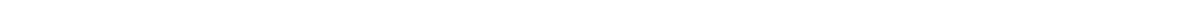
Fig. 3 Transcriptome-wide analyses of puri fi ed mouse astrocytes treated with EphB1 or IL-6. a Graphs show the total of changed transcripts induced by EphB1 or IL-6 treatment. b Diagram demonstrating the number of treatment speci fi c and commonly upregulated and downregulated genes ( n = 2 independent cultures from 6 mice; FDR ≤ 0.1). c Unsupervised hierarchical clustering of control astrocytes (ACs), IL-6 and EphB1-treated gene expression pro fi les demonstrates separation of each experimental group. Heatmaps show the representation of top genes by contribution to Principal Component. Vertical colour bar indicates groupings of genes according to patterns of change in response to EphB1 and IL-6. Gene expression data represent SD from mean of variance stabilised values across rows. Upregulated genes are shown in red, downregulated genes are shown in blue. d GO term analysis of signi fi cantly induced genes (FDR ≤ 0.1) when comparing EphB1 to IL-6 treatment using the DAVID interface. e , f Signi fi cantly induced transcripts by EphB1 in comparison with IL-6-induced response, representing pro-in fl ammatory/immune-regulator genes ( e ) or homeostatic/cell defence ( f ) astrocyte reactivity pro fi les. For IL-6 non-signi fi cant changes are represented by empty bars. Orange dots label commonly upregulated transcripts of reactive astrocytes de fi ned by published data 8 . g Signi fi cant EphB1-induced or IL-6-induced TFs in which STAT3 activators are labelled in red. h Heatmaps of STAT3 targets induced by either EPhB1 or IL-6 treatment of astrocytes. Stars represent signi fi cantly induced transcripts ( p ≤ 0.01) and data represent SD from mean. For graphs data shows log2-fold changes in gene expression ±